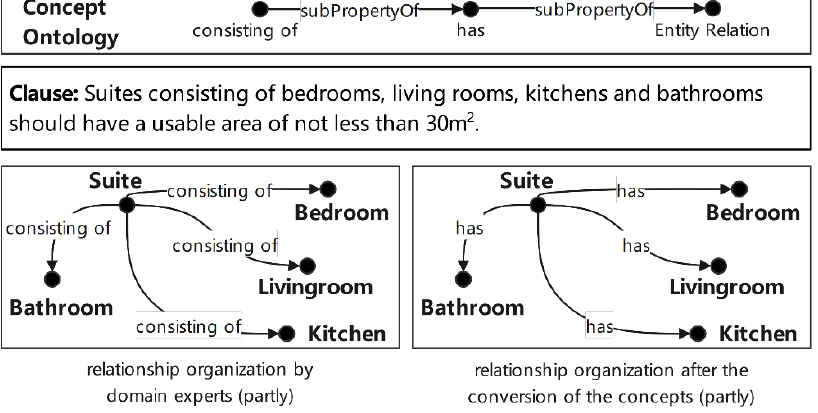
Figure 6. An example to illustrate the conversion between the matched concepts and their related formal descriptions in the concept ontology when developing a clause-entity knowledge graph.